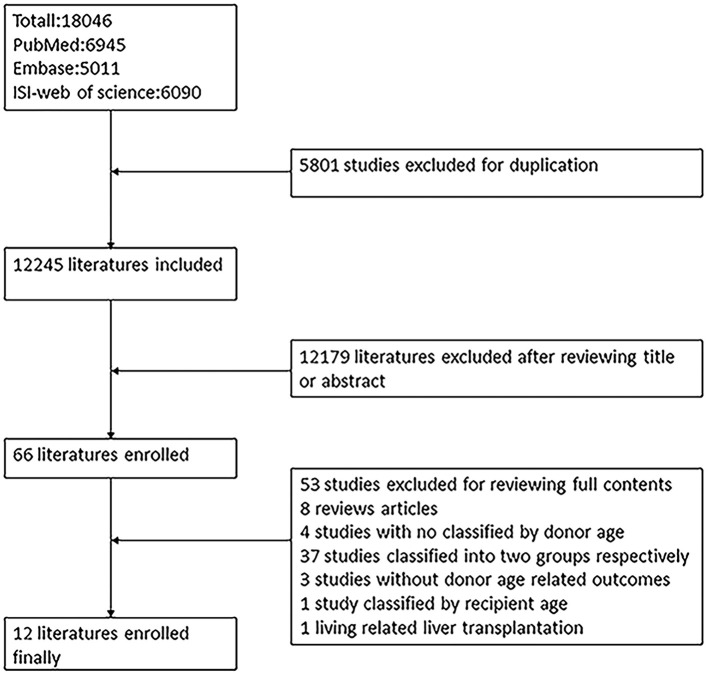
Flow diagram on selection of eligible studies.